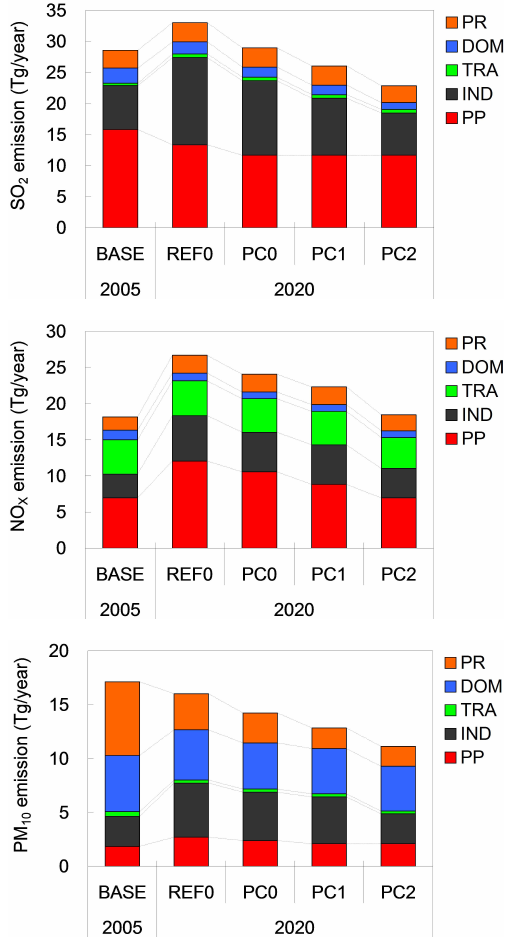
Fig. 2. Contribution of each sector to total emissions in China (PP – Power plants; IND – Industry; DOM – Domestic; TRA – Transport; PR – Industry process). (a) SO 2 , (b) NO x , (c) PM 10